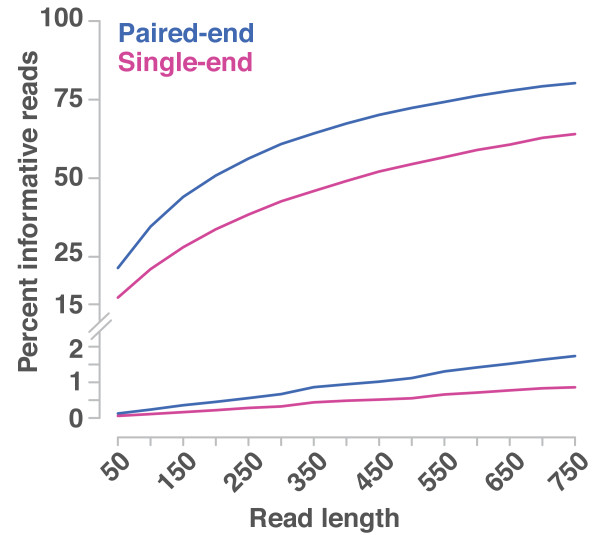
Percentage of informative reads for different sequencing read lengths and types. Reads or read pairs, respectively, can only contribute to mapping-by-sequencing if their alignments overlap with at least one marker or mutations (informative reads). The number of informative reads from single-end and paired-end sequencing are shown in purple and blue, respectively. The lower graphs refer to a mutation density, which is typical for backcross populations (here, 1,400 mutations per mutant genome). The upper graphs refer to the number of marker in outcross populations (281,668 and 291,973 for single-end and paired-end sequencing).